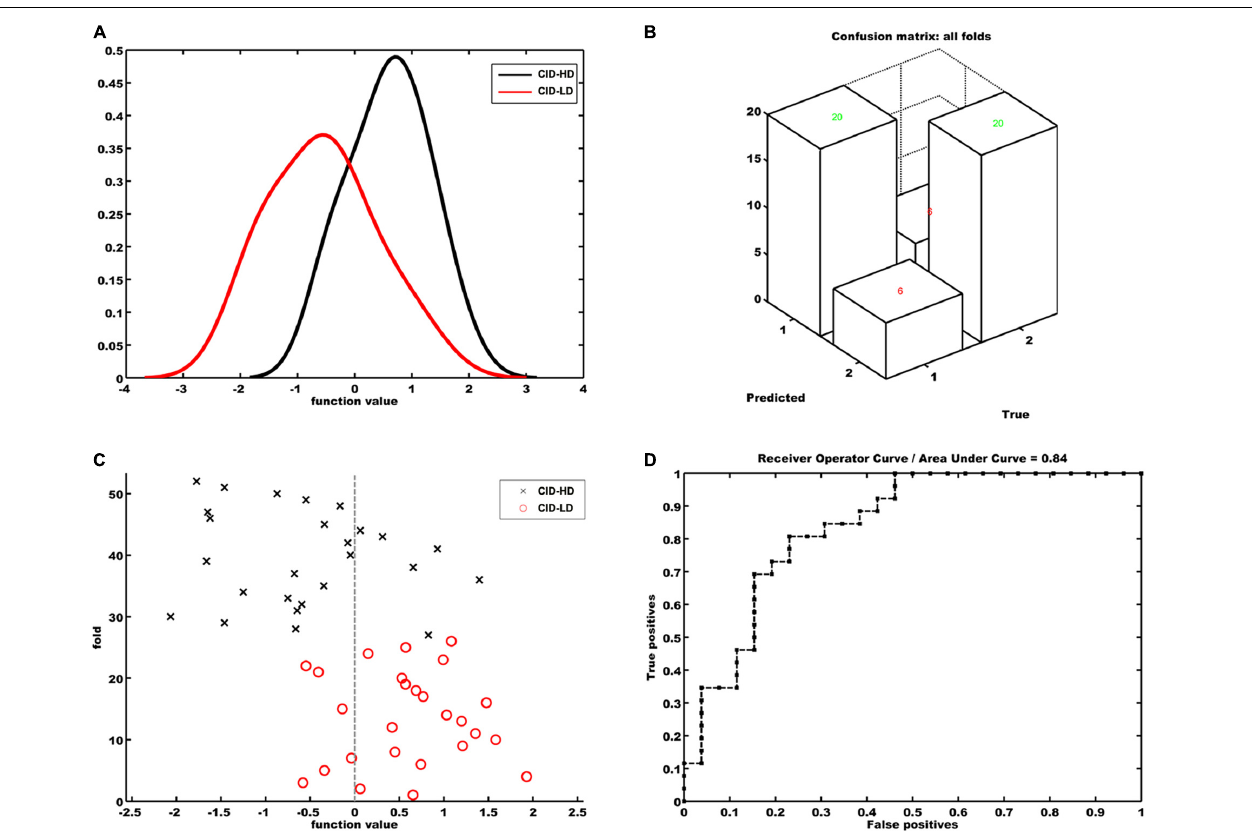
FIGURE 2 | Classification model for discriminating CID-HD from CID-LD patients based on the functional connectivity map of the right anterior orbital frontal cortex. (A) Histogram of function values for each group. (B) Confusion matrix of all folds. (C) Prediction values per fold of the classification model. Positive function values for CID-LD patients indicate true positives. Negative function values for CID-HD participants indicate true negatives. (D) Receiver operating characteristic curve (ROC) showing the area under the curve was 0.84. True positives = sensitivity; false-positives = 1 – specificity.